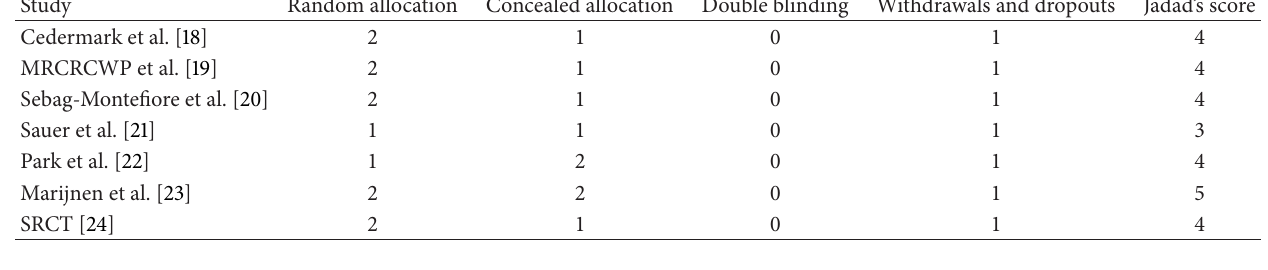
Table 2: Jadad score of included trials.